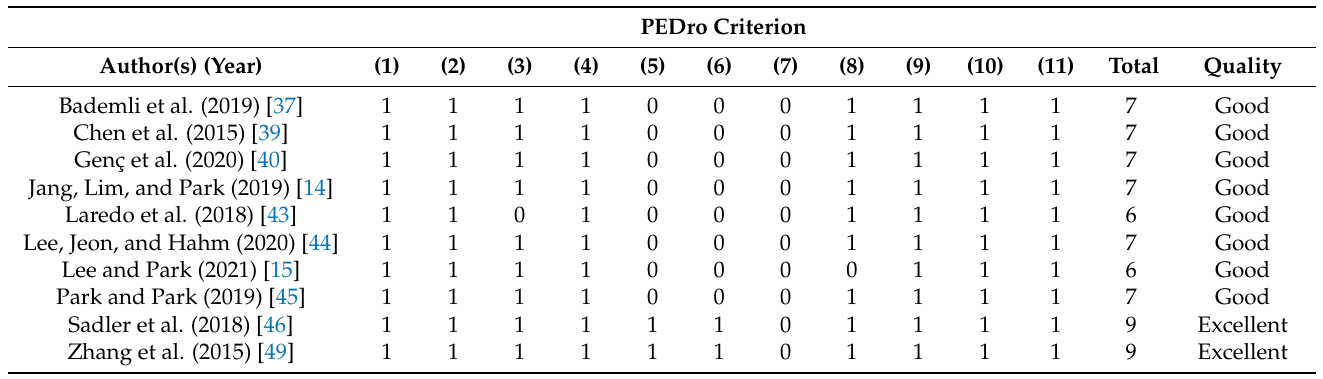
Table 2. Methodological scores assigned to the RCTs.